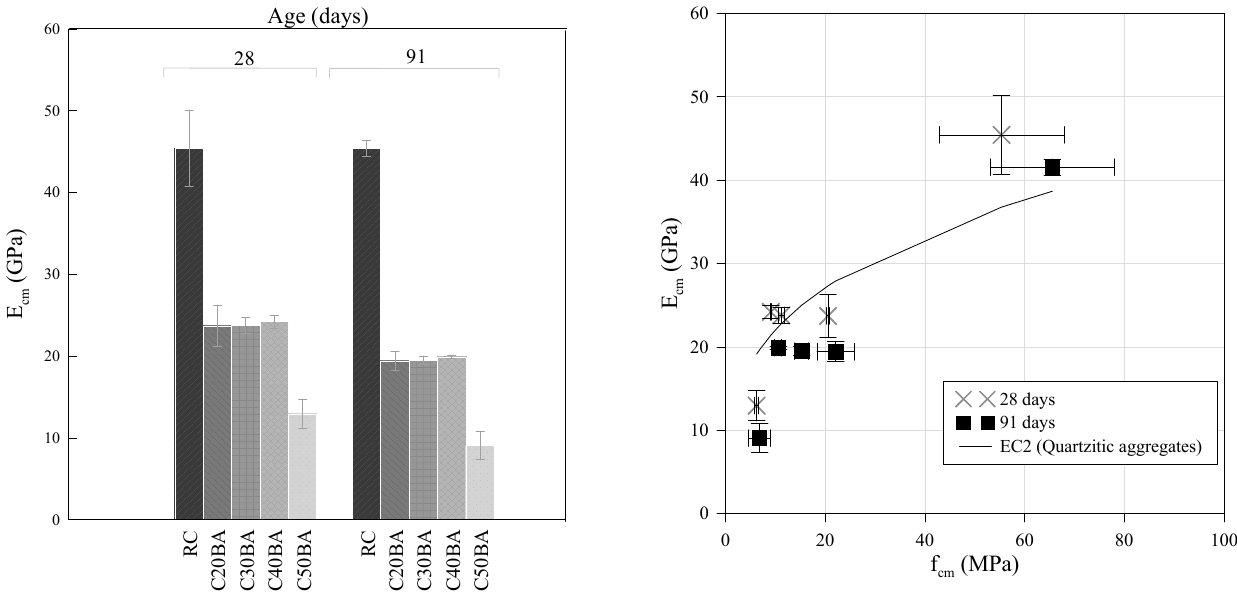
Figure 5. Modulus of elasticity (E cm ) at 28 and 91 days ( left ); relationship between E cm and f cm at 28 and 91 days ( right ). Table 7. E cm vs. f cm according to Eurocode 2 [39] at 28 and 91 days.